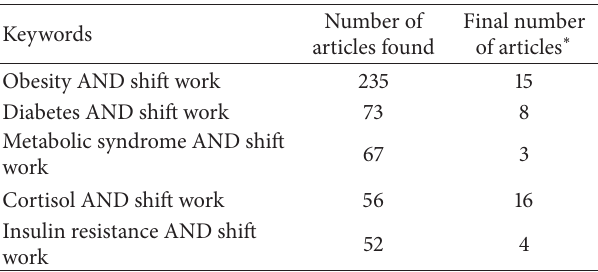
Table 1: Number of articles and criteria of inclusion, according to the keywords used in this